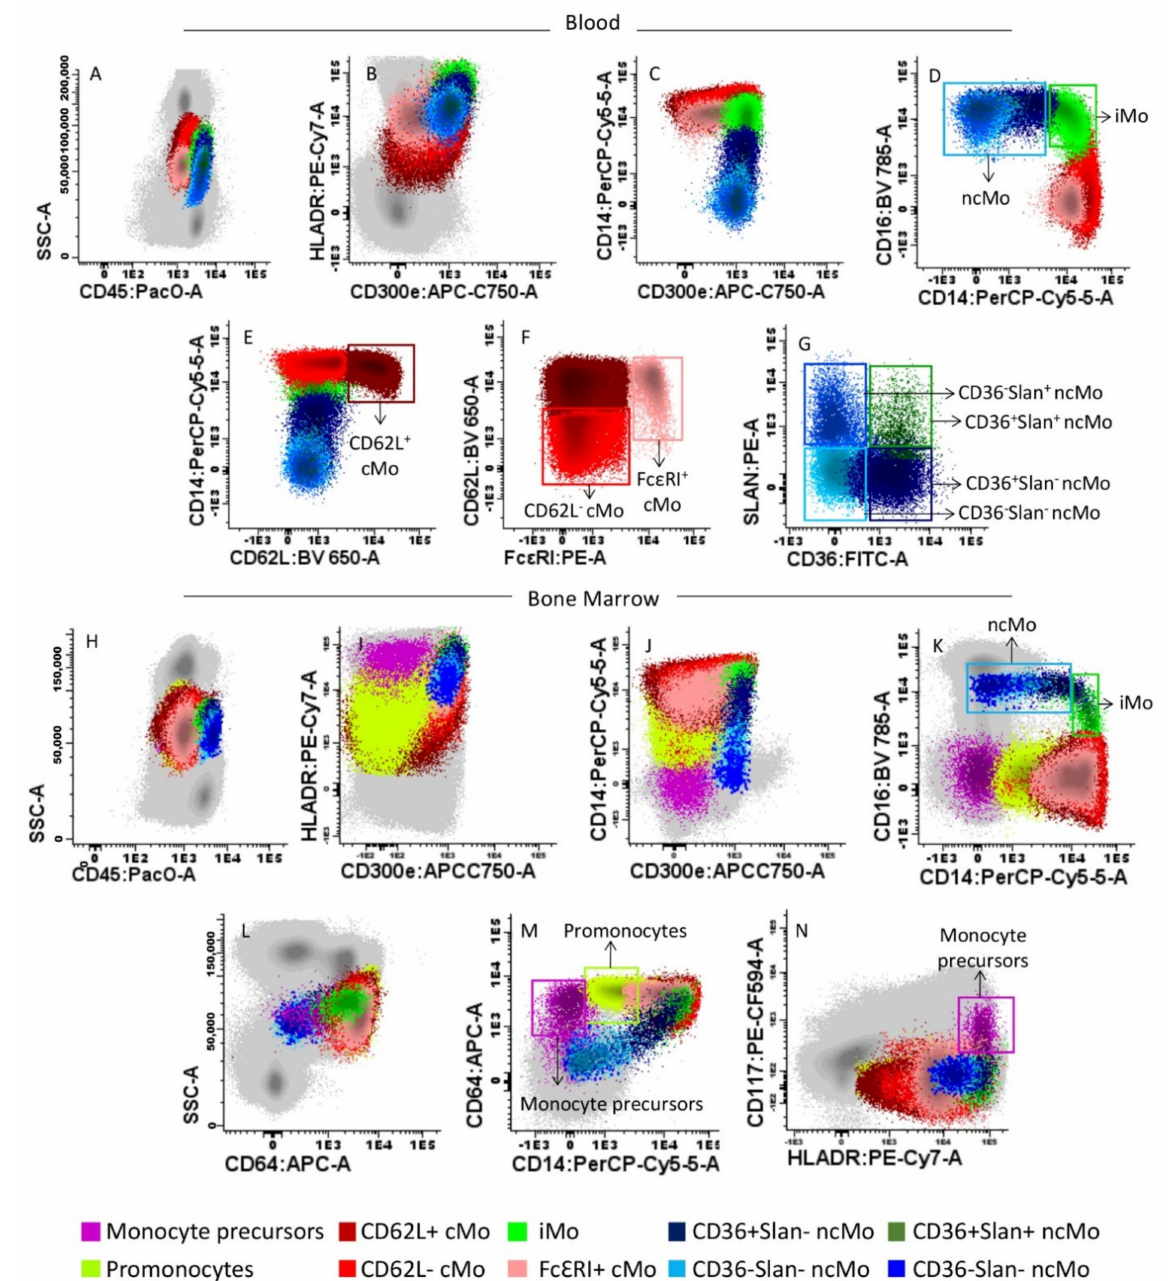
Figure 1. Gating strategy used for the identification of monocytes (Mo) and their different subsets in representative peripheral blood (PB) (upper panels A – G ) and bone marrow (BM) (lower panels H – N ) samples from a healthy donor (HD). The distinct blood (panels A – G ) and BM (panels H – N ) subsets of Mo identified are represented as colored events, after they had been gated and discriminated from all other PB and BM leucocytes (gray dots) based on their typical SSC/CD45 profile (panels A , H ), and their unique positivity for CD300e, HLADR, CD64 and CD14 (panels B , C , I , J , M ). Within total (mature) Mo, the following subsets were identified based on their distinct expression profile for CD14 and CD16 (panels D , K ) plus Fc ε RI (panel F ): CD14 hi CD16 − classical (c)Mo, CD14 hi CD16 + intermediate (i) Mo, and CD14 − /lo CD16 + non-classical (nc)Mo and the subset of CD14 + CD16 − Fc ε RI + cMo. Within cMo, the CD62L + and CD62L − subsets were further identified (panel E ), while ncMo were further separated into CD36 + Slan − , CD36 − Slan − , CD36 + Slan + and CD36 − Slan+ ncMo (Panel G ). In BM samples, monoblasts and promonocytes were additionally identified, based on their phenotypic profile (positivity) for both CD117, HLADR (panels N ) and expression of CD64 (panel L , M